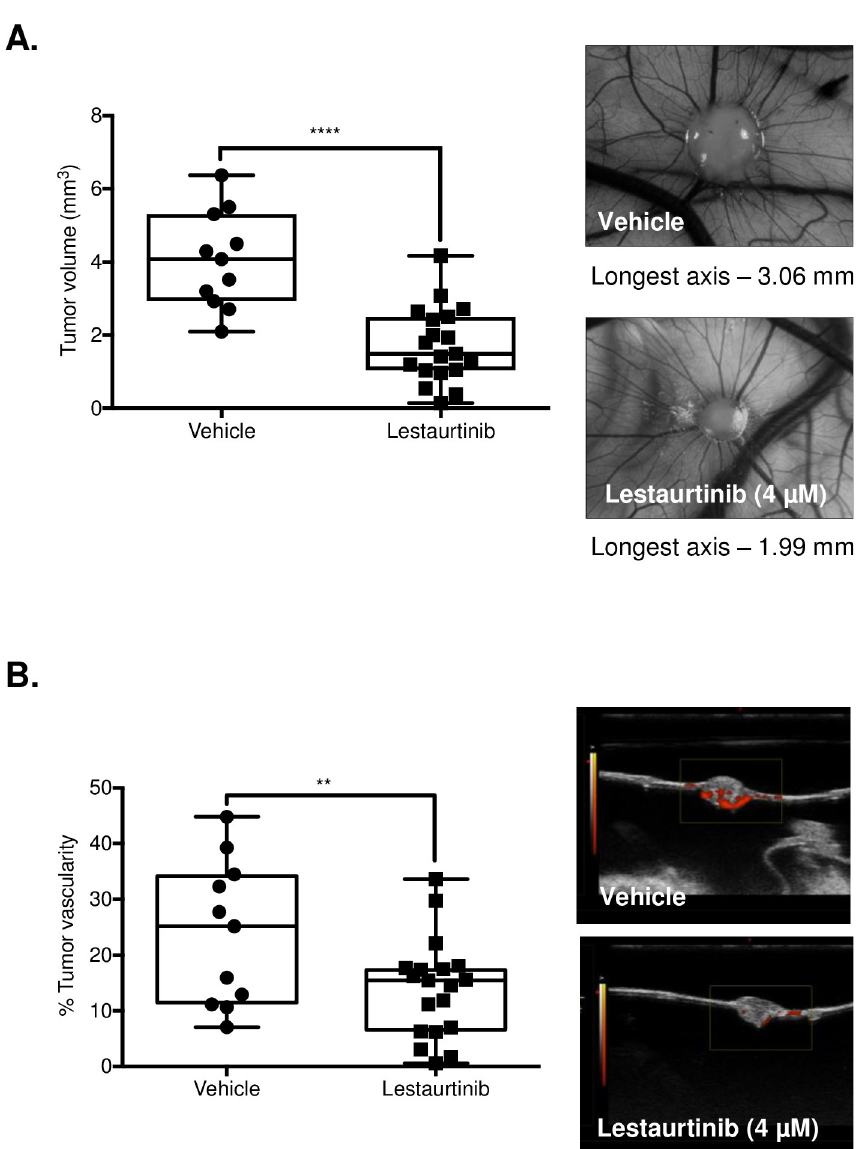
Fig 5. Lestaurtinib exhibits antiproliferative and antiangiogenic activity in the in vivo chick CAM membrane model. (A) A total of 1 x 10 6 cells per embryo were administered over top (onplant) of the chick embryo membrane, 9 days post-fertilization. Two days post-onplant, embryos were either treated with the vehicle alone or Lestaurtinib (4 μ M), once daily for 5 days and sacrificed. Mean endpoint tumor volume was measured using ultrasound imaging in the vehicle-treated (n = 11) and Lestaurtinib-treated (n = 19) embryos. (B) Power Doppler ultrasound imaging measured the intergroup difference in fractional vascular volume at endpoint to generate mean percent vascularity between groups. � represents p < 0.05, �� represents p < 0.01, ��� represents p < 0.001, ���� represents p < 0.0001, ns = not significant, Student’s unpaired, two-tail t -test.